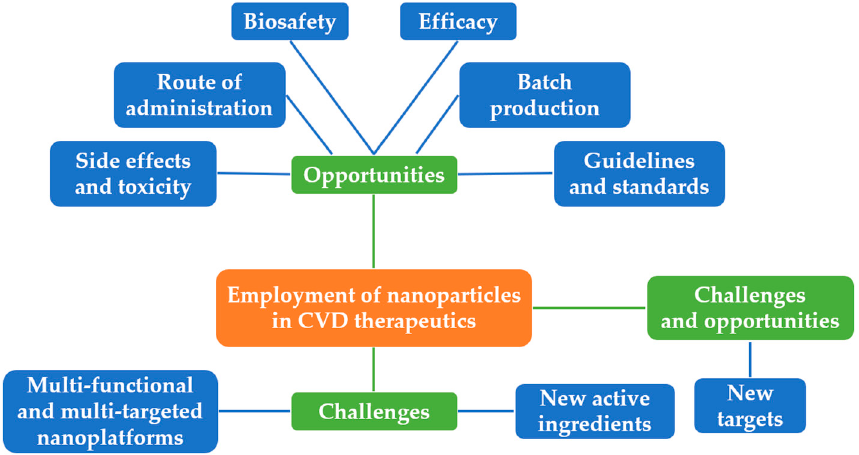
Figure 3. Challenges and opportunities of the employment of nanoparticles in CVD therapeutics.